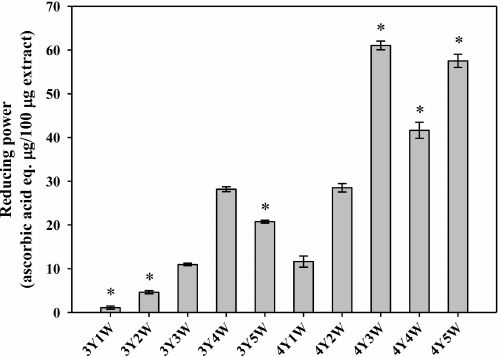
Figure 2. Reducing power of ginseng berry extracts harvested at various time points. Rectangular bars and their error bars represent means and standard deviations, respectively ( n = 3). The ‘ m Y n W’ on the x-axis means